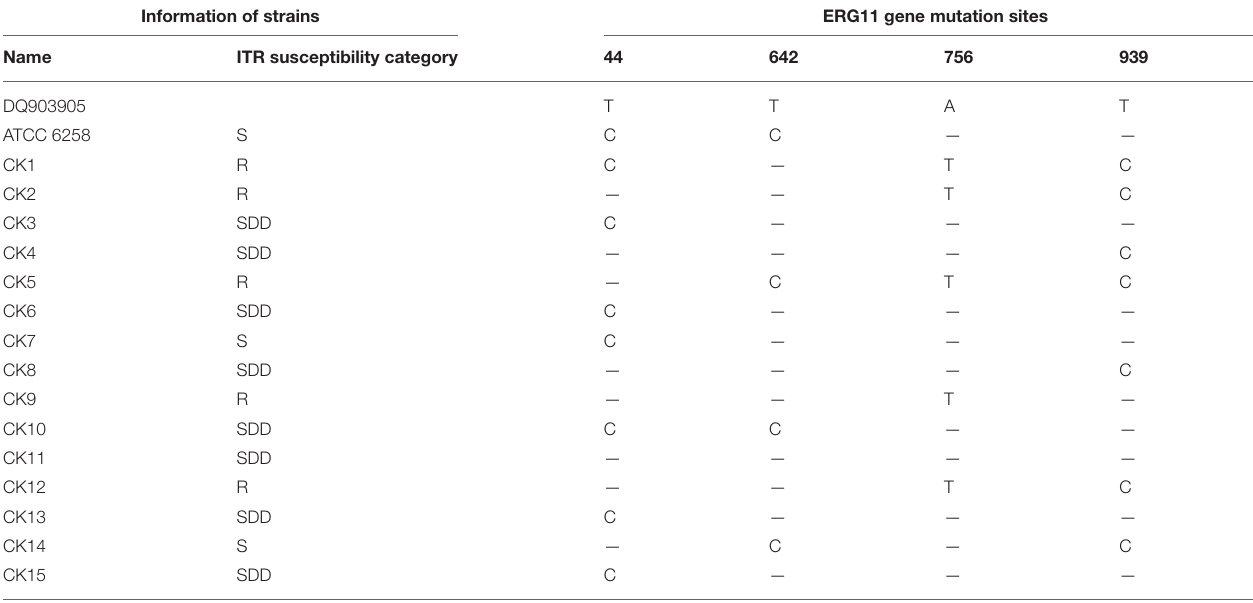
TABLE 4 | ERG11 gene point mutations in C. krusei clinical isolates.